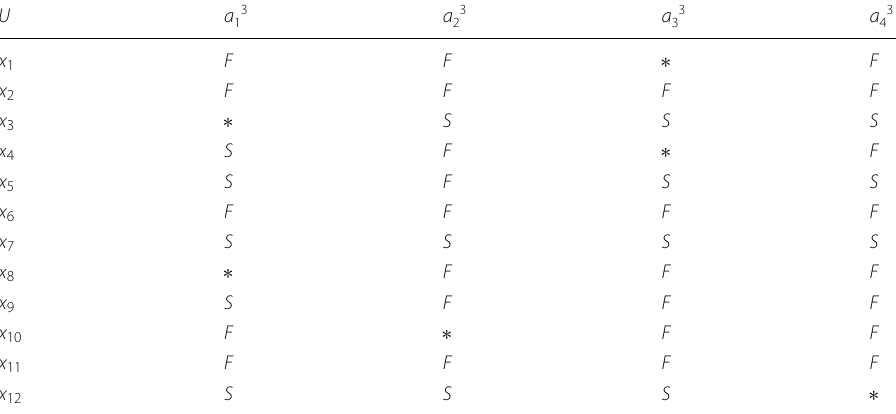
Table 4 The incomplete ordered information table with the third level of